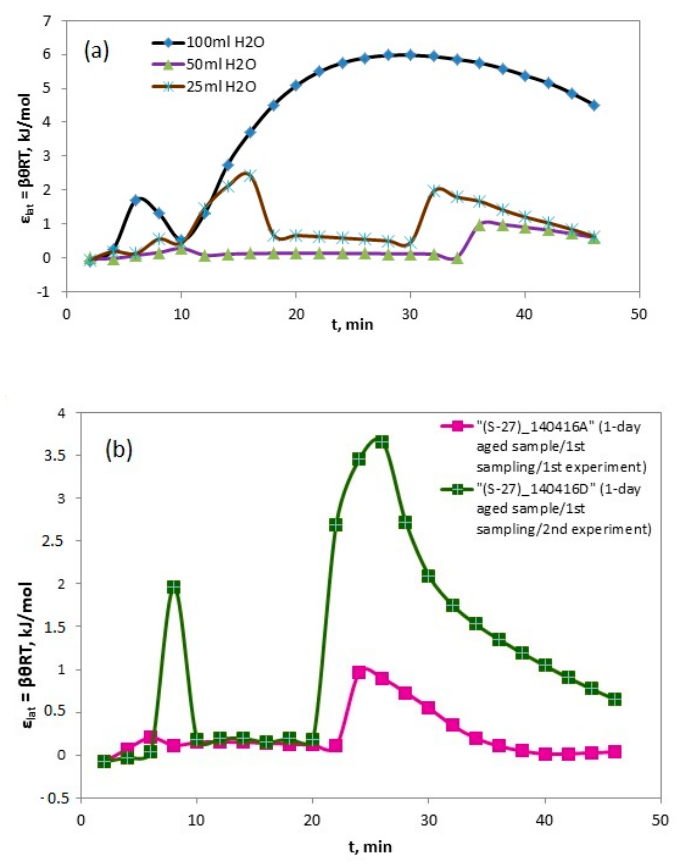
Figure 8. Time-distribution of the lateral local adsorption energies among adsorbed species for the powdered catalyst samples: ( a ) S-27 (prepared at different quantities of water) and ( b ) S-27 (75 mL H 2 O, 1 day aged).